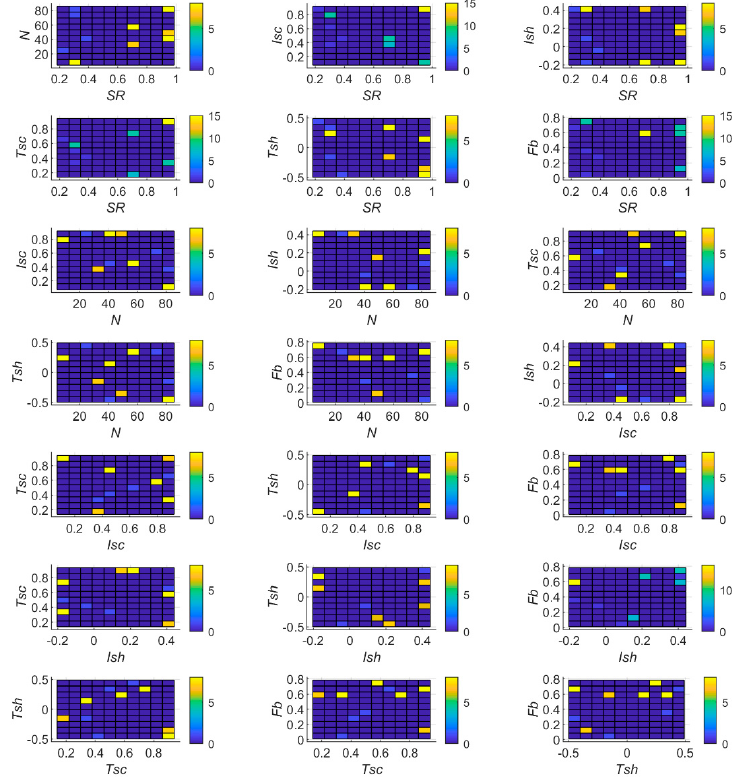
Figure 8. Best hyperparameters frequency for the Polish dataset errors using LCB-BO optimized